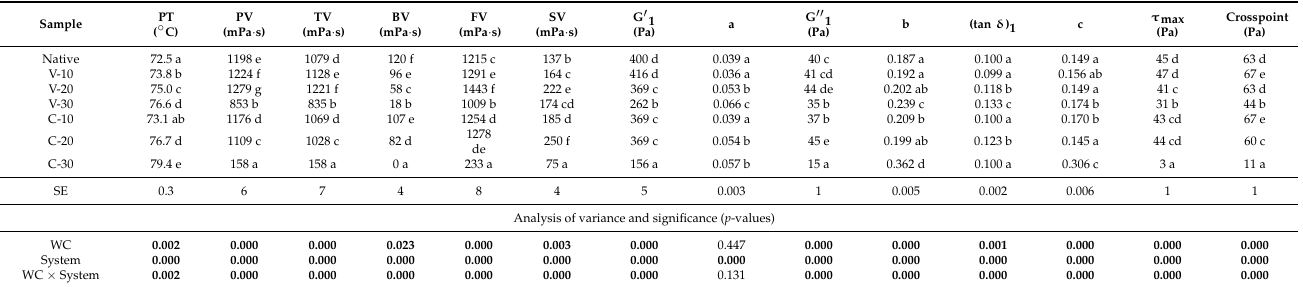
Table 3. Pasting properties of flour samples and rheological properties of gels obtained from untreated (native) and microwave-treated quinoa